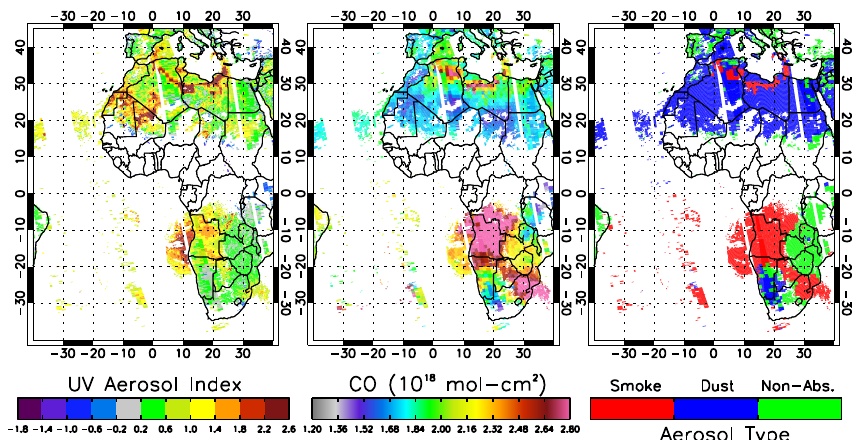
Fig. 3. Aerosol type determination over Africa on 27 August 2007 (see text for